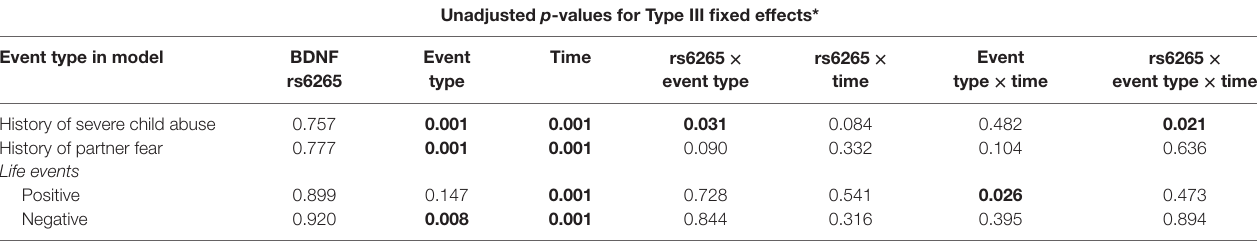
Bolded values indicate p <